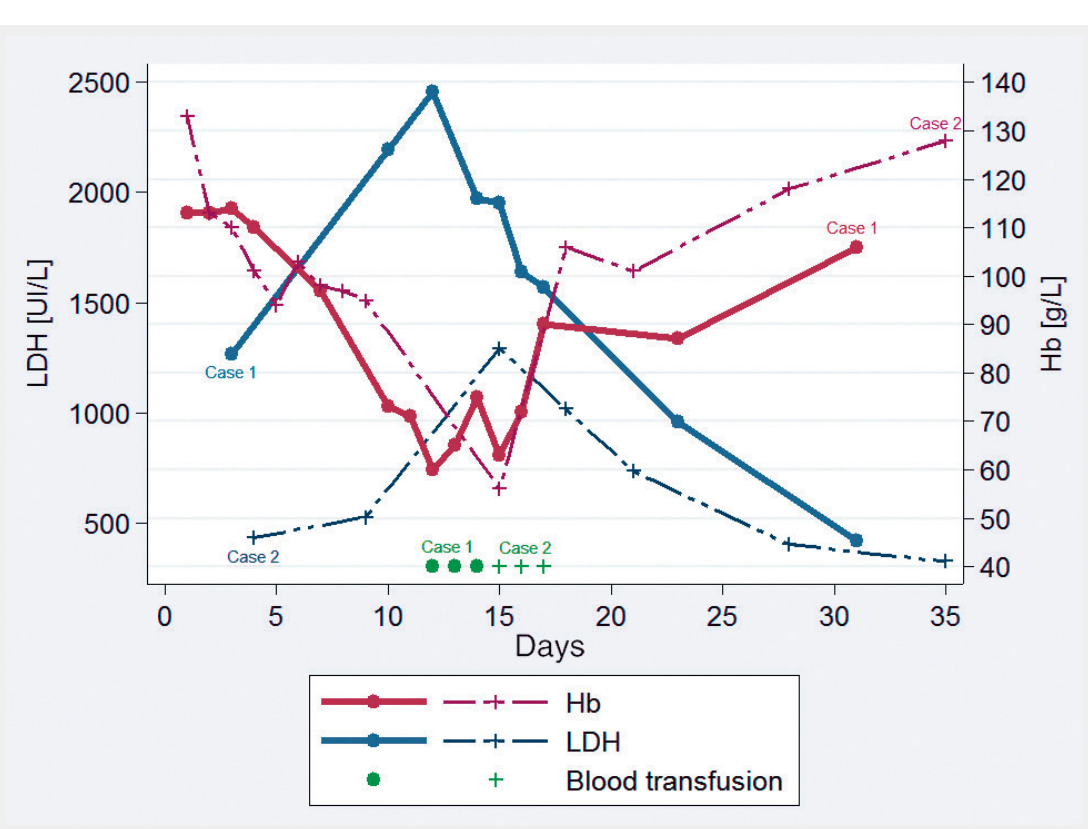
Time course of haemoglobin (Hb) levels and lactate dehydrogenase (LDH) levels in case 1 and case 2 (delayed pattern). N.B.: Because of the low number of LDH data, case 3 is not